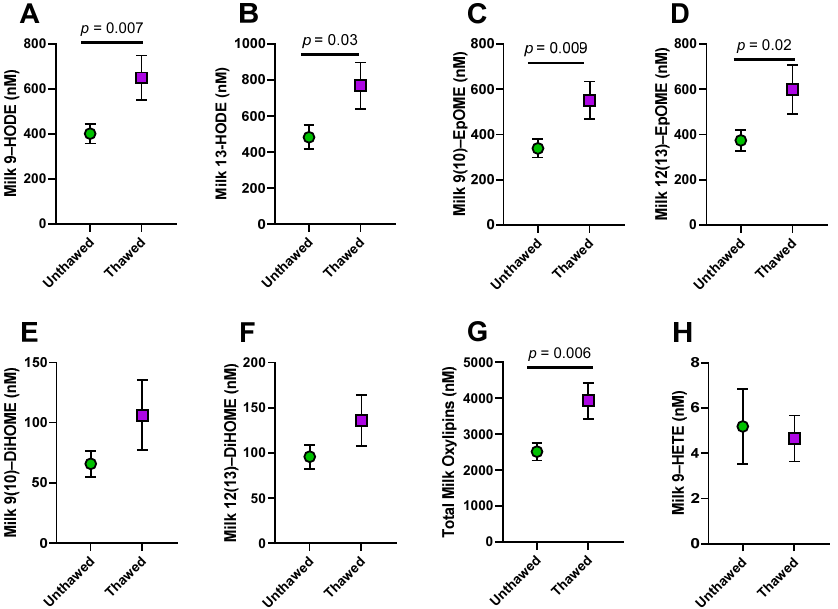
Figure 3. Differences in milk total oxylipins between unthawed samples and samples with previous freeze–thaw cycles. Samples were collected as part of a case–control study of low milk supply. In this study, unthawed samples were not available for all subjects, so we tested for differences with previous freeze–thaw cycles. Total oxylipin (esterified + non-esterified) concentrations were higher with previous thawing for ( A ) 9-hydroxy octadecadienoic acid (9-HODE), ( B ) 13-HODE, ( C ) 9(10)-epoxy octadecamonoenoic acid (9(10)-EpOME), ( D ) 12(13)-EpOME, ( E ) 9(10)-dihydroxy octadecamonoenoic acid (9(10)-DiHOME), ( F ) 12(13)-DiHOME, and ( G ) Total Oxylipins, although the difference was not statistically significant for DiHOMEs. In contrast, ( H ) 9-hydroxy eicosatetraenoic acid (9-HETE), a marker of autoxidation, was not different from previous thawing. Unthawed, n = 36; Previously thawed, n = 10. Differences assessed by t -test. Data graphed as mean ±SEM.